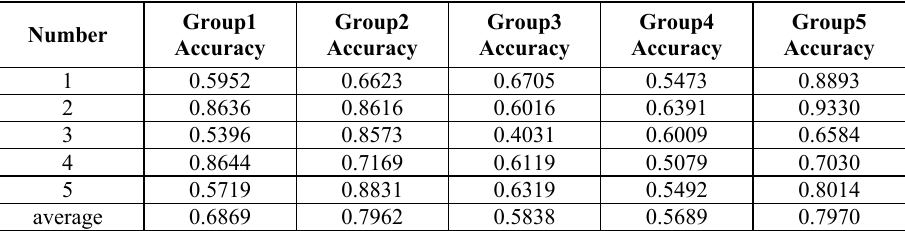
Table 2. 7-3 Forecast accuracy rate statistics.